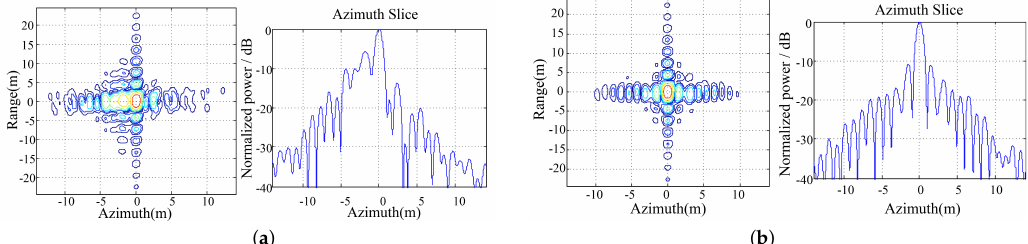
Figure 12. The scintillation mitigation on point target. ( a ) Scintillation imaging result for C k L = 10 33 . ( b ) The autofocusing result.